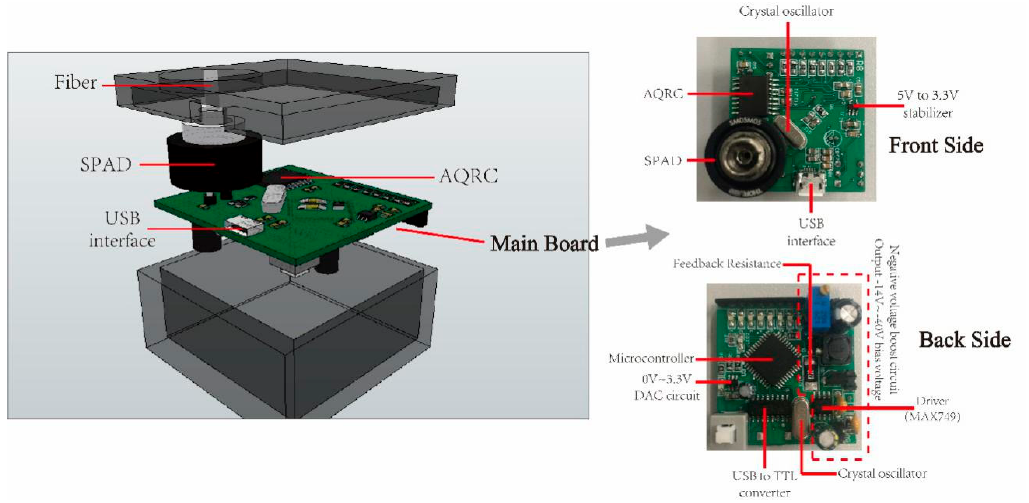
Figure 4. The assembled single-photon counting module.